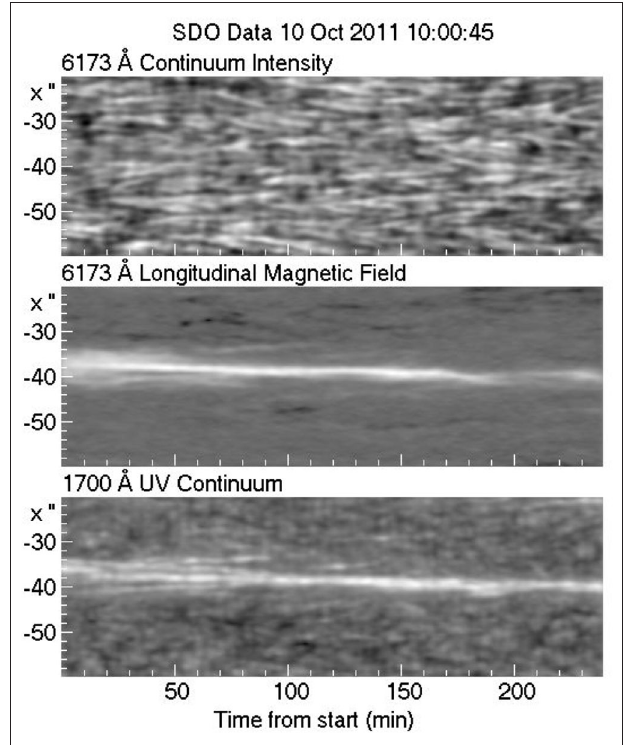
FIGURE 15 | Position (vertical axis) - time (horizontal axis) cuts through a magnetic element. Granular motions are clearly visible in the top panel; the middle and the bottom panels show the motion of the magnetic element and the corresponding bright point in the 1700Å band. A low pass filter has been applied in the time domain to reduce the effect of the 5 min oscillations. Figure prepared by the author from SDO data.